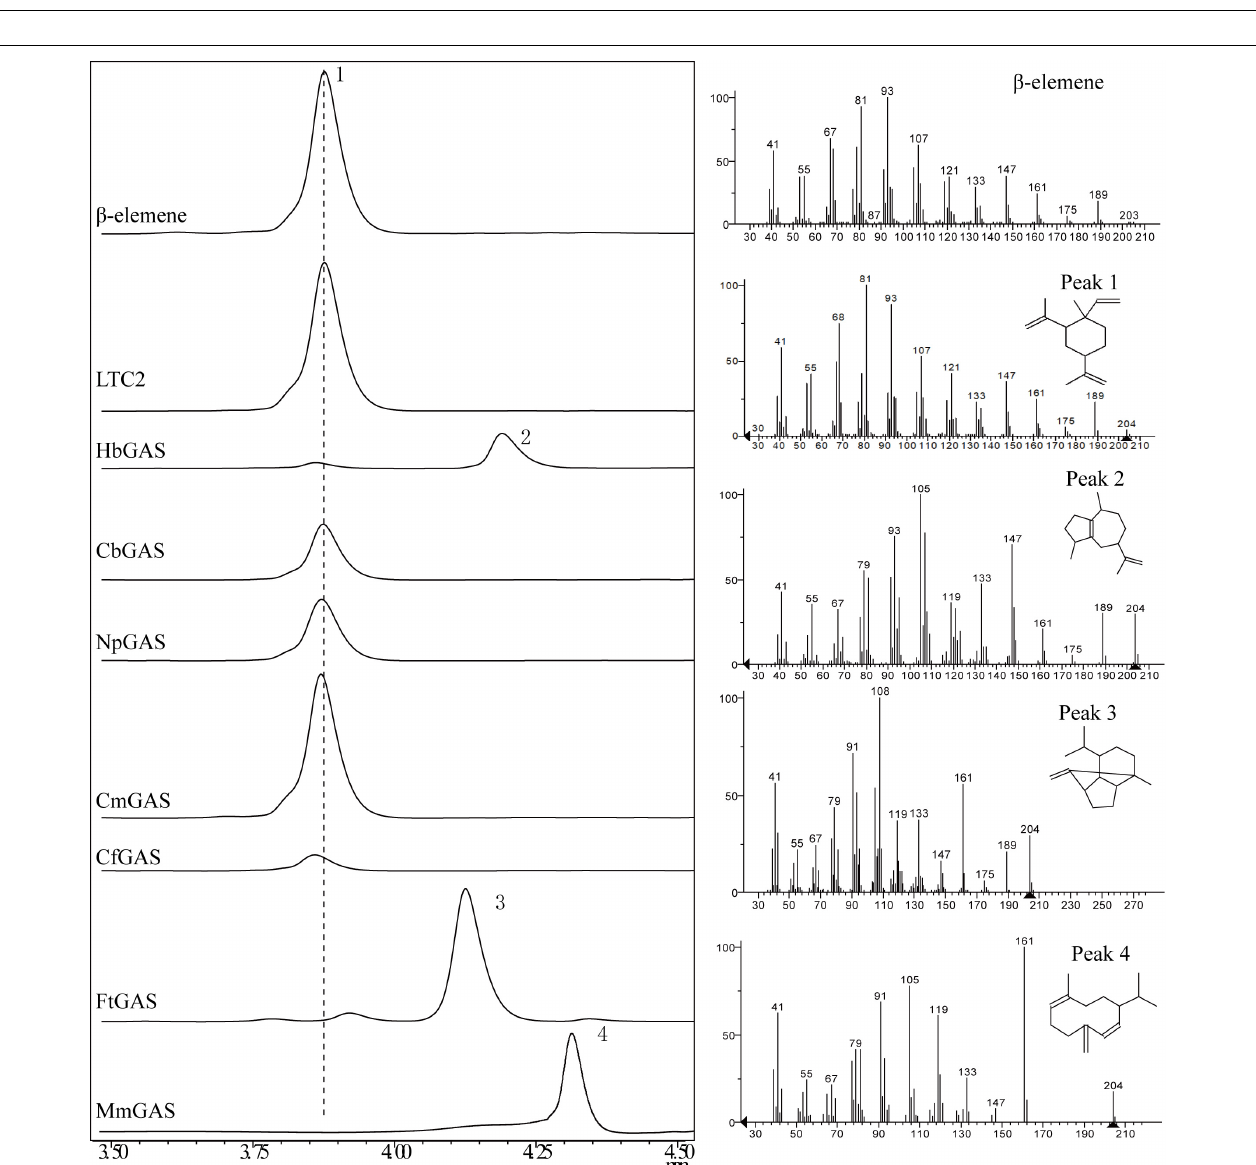
FIGURE 2 | GC-MS analysis of products in E. coli BL21Star (DE3) pMM- GASs. Peaks 1, β -elemene; 2, guaiene; 3, sativene; 4, germacrene D.